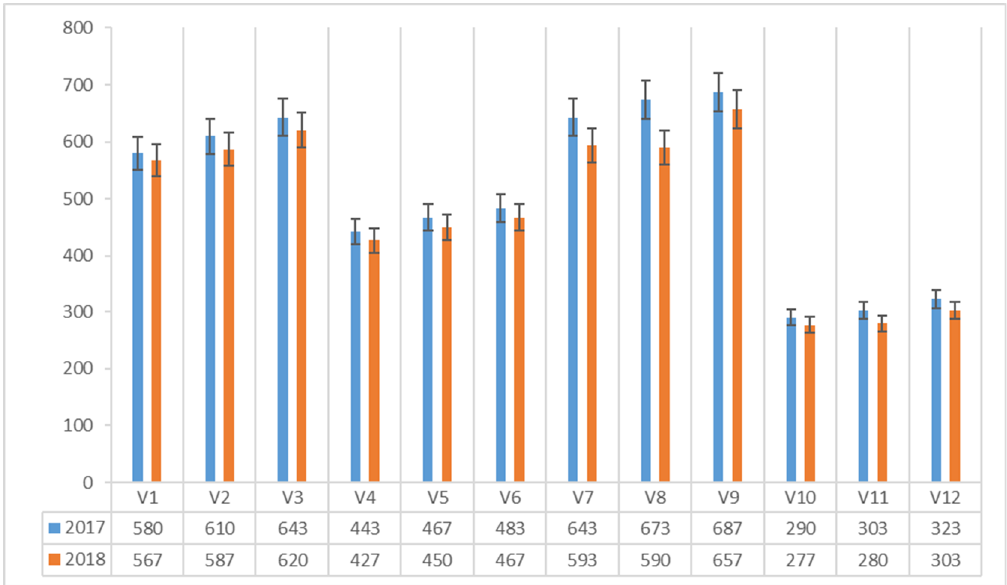
Figure 4. Vitamin B 2 vitamin content of Agaricus blazei Murrill mushrooms (μg 100g −1 dm) in two years of experiments.